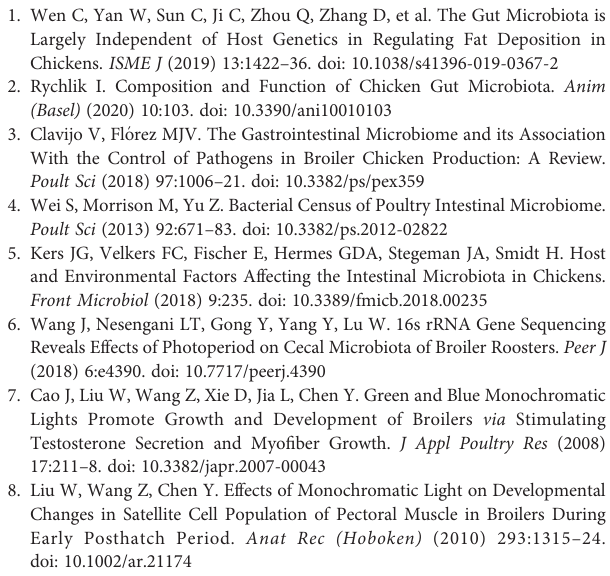
Supplementary Figure 1 | Kyoto Encyclopedia of Genes and Genomes (KEGG) pathway difference analysis between WW and G ! B groups (A) . KEGG pathway enrichment analysis between WW and G ! B groups (B) . WW, white light; RR, red light; GG, green light; BB, blue light; G ! B, green light and blue light combination. The results are presented as means ± SEM. Different letters indicate signi fi cant differences between the treatments at the same age ( P < 0.05). Supplementary Figure 2 | Relationships among phenotypic variables, the microbial community, and metabolic butyrate concentration. Pairwise comparisons of phenotypic variables with a color gradient denoting Spearman correlation coef fi cient. The microbial community and metabolic butyrate concentration were related to each phenotypic variable by Mantel correlation (based on Bray – Curtis dissimilarity). The edge width represents the statistical signi fi cance for the corresponding distance correlations, and the edge color denotes Mantel ’ s r statistic. * P < 0.05; ** P < 0.01; *** P <